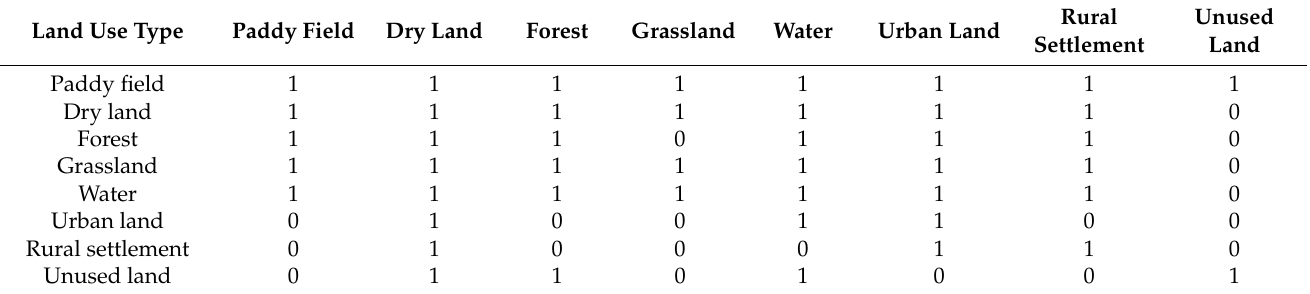
Table A2. Land use conversion cost matrix of model validation.